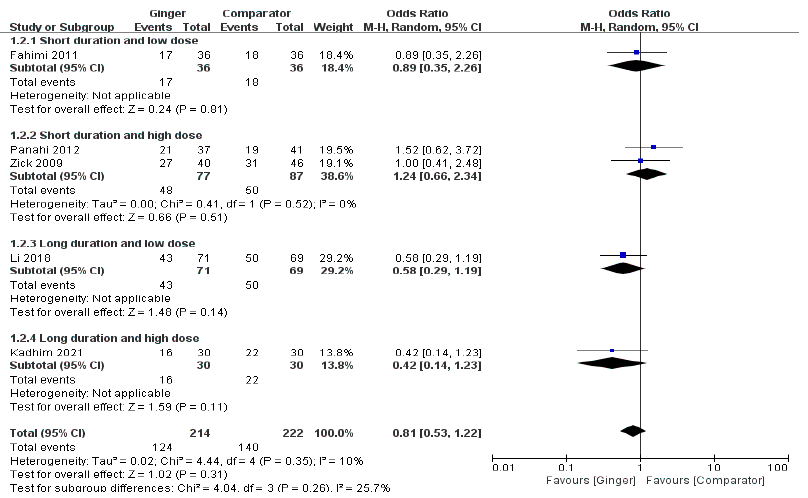
Figure 3. Effects of ginger intake on chemotherapy-induced delayed nausea. Short duration ≤ 4 days; Long duration > 4 days; Low dose ≤ 1 g/day; High dose > 1 g/day. Fahimi 2011 [19], Panahi 2012